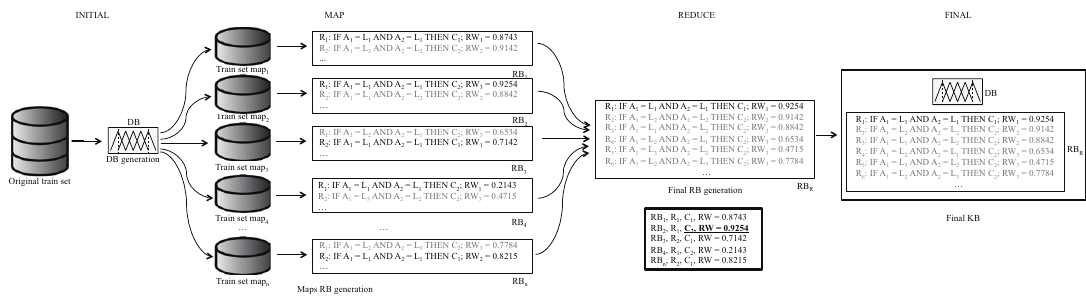
Figure 3: Example of building the KB with Chi-FRBCS-BigData-Max rules with the same antecedent. Then, the average weight of the rules that have the same consequent is computed (this step is needed because rules with the same antecedent and consequent may have different weights as they are built over different training sets). Finally, the rule with the greatest average weight is kept in the final RB, RB R